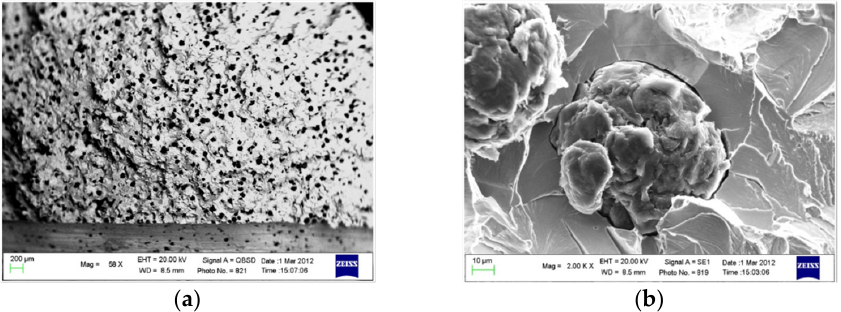
Figure 4. Micrograph details: ( a ) a completely nodular area (58×); ( b ) the spherical morphology of the graphite nodules (2000×).